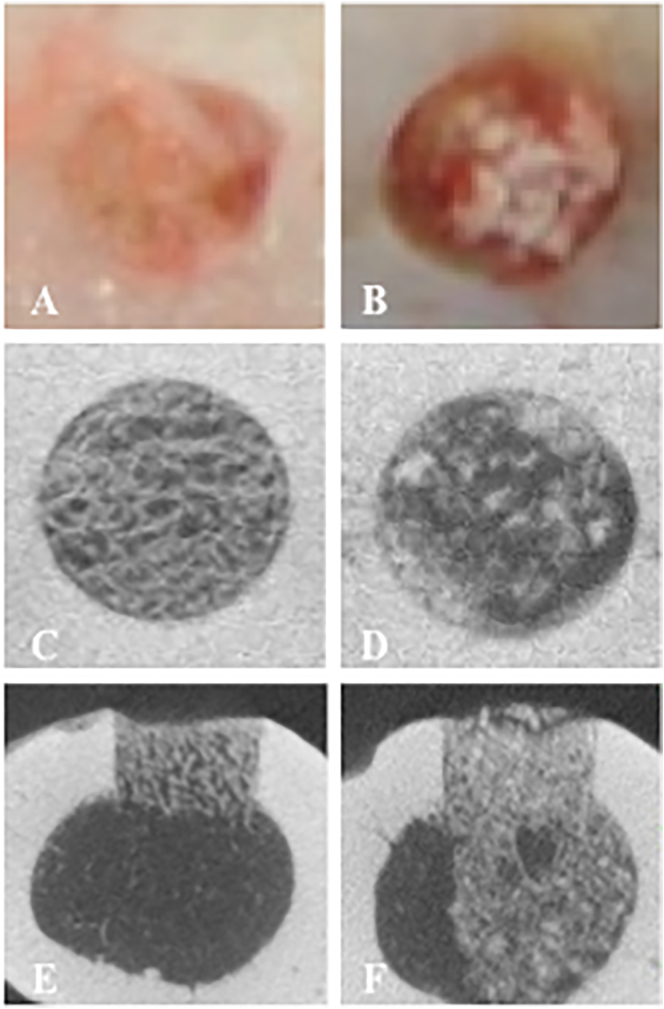
Microscopic and micro-CT pictures 4 weeks after implantation. Macroscopic observation on the surfaces of drill holes implanted with (A) β-TCP/PDLGA and (B) β-TCP. Micro-CT on the surface of drill holes implanted with (C) β-TCP/PDLGA and (D) β-TCP. Cross sectional micro-CT of drill holes implanted with (E) β-TCP/PDLGA and (F) β-TCP. Homogeneous surface was seen at (A) and (C), but remnants of β-TCP was seen at (B) and (D). Medullary cavity was remodeled at (E), but formed bone and material remnants were seen at medullary region of (F).